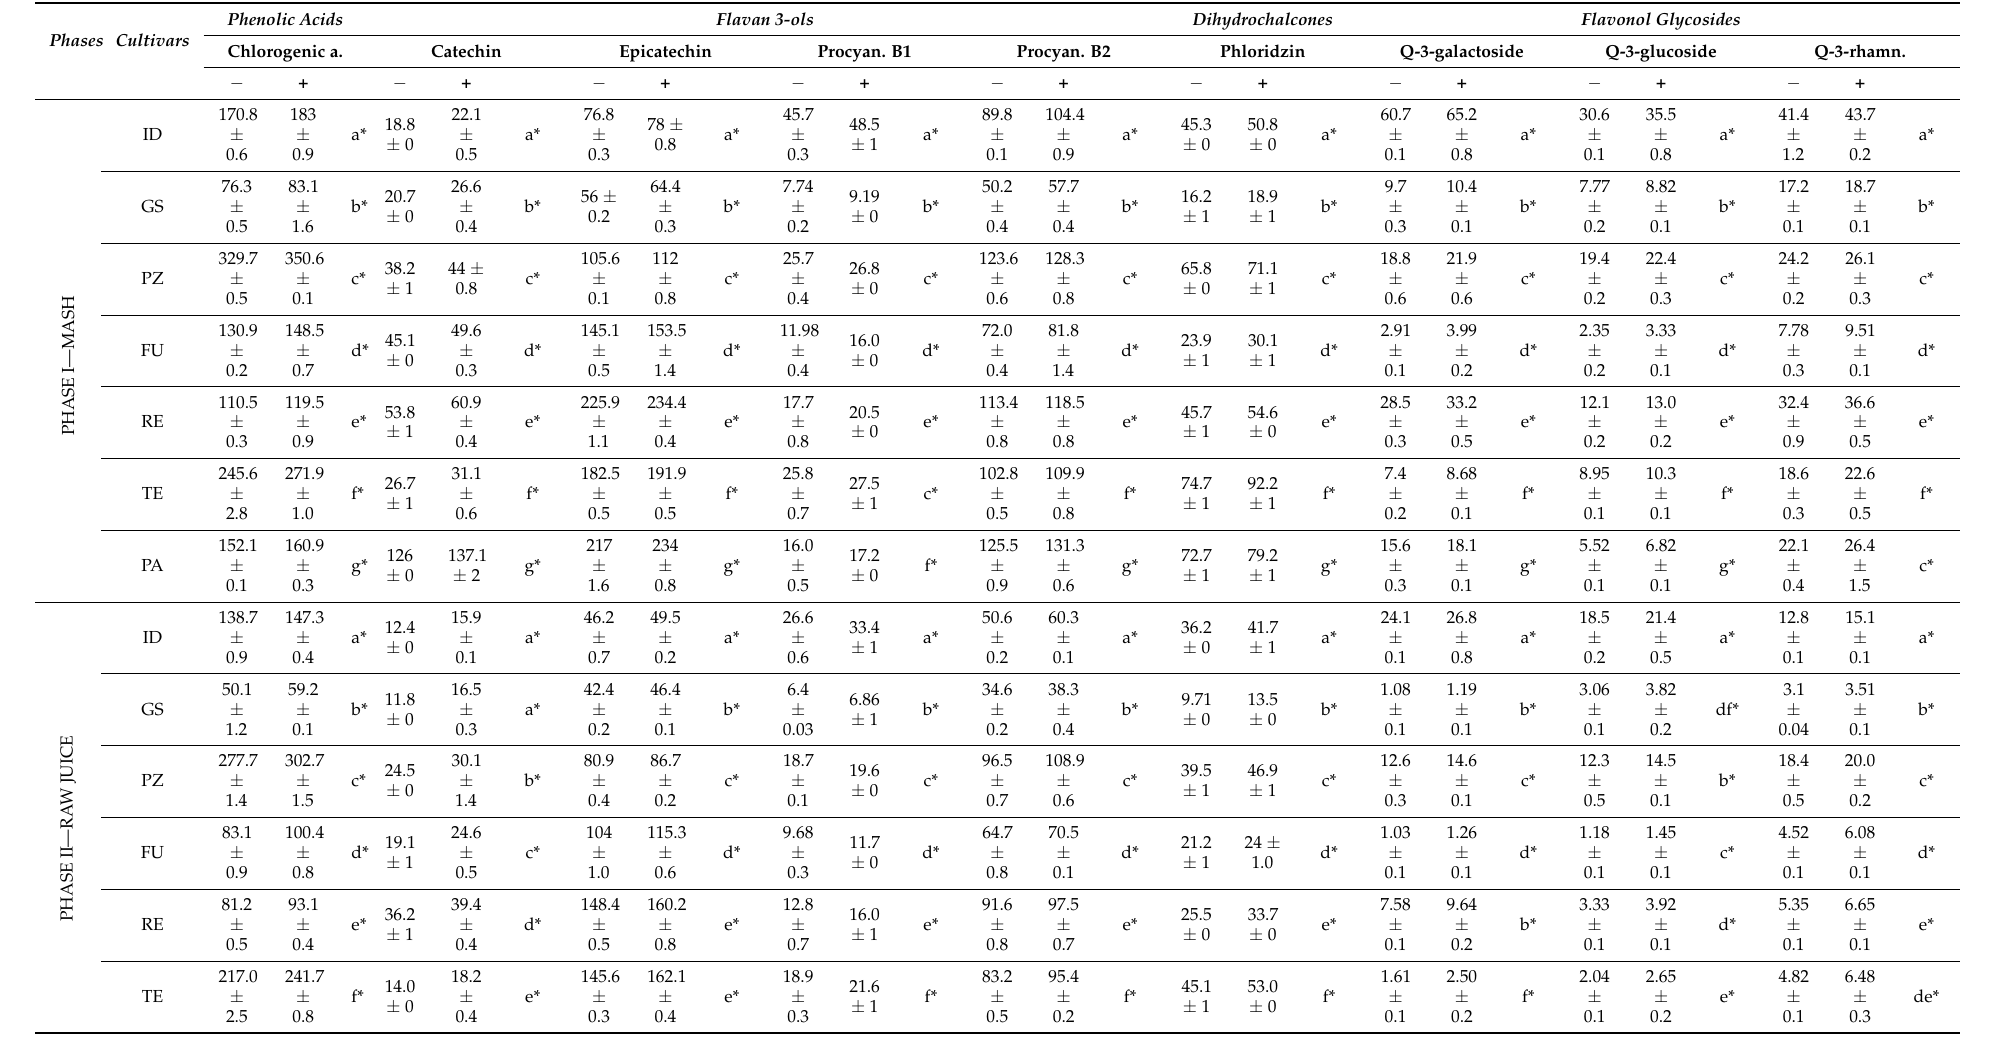
Table 3. Distribution of polyphenols content throughout different phases of juice production (mg kg − 1 for mash; mg L − 1 for juices). Phenolic Acids Flavan 3-ols Dihydrochalcones Flavonol Glycosides Phases Cultivars Chlorogenic a. Catechin Epicatechin Procyan. B1 Procyan. B2 Phloridzin Q-3-galactoside Q-3-glucoside